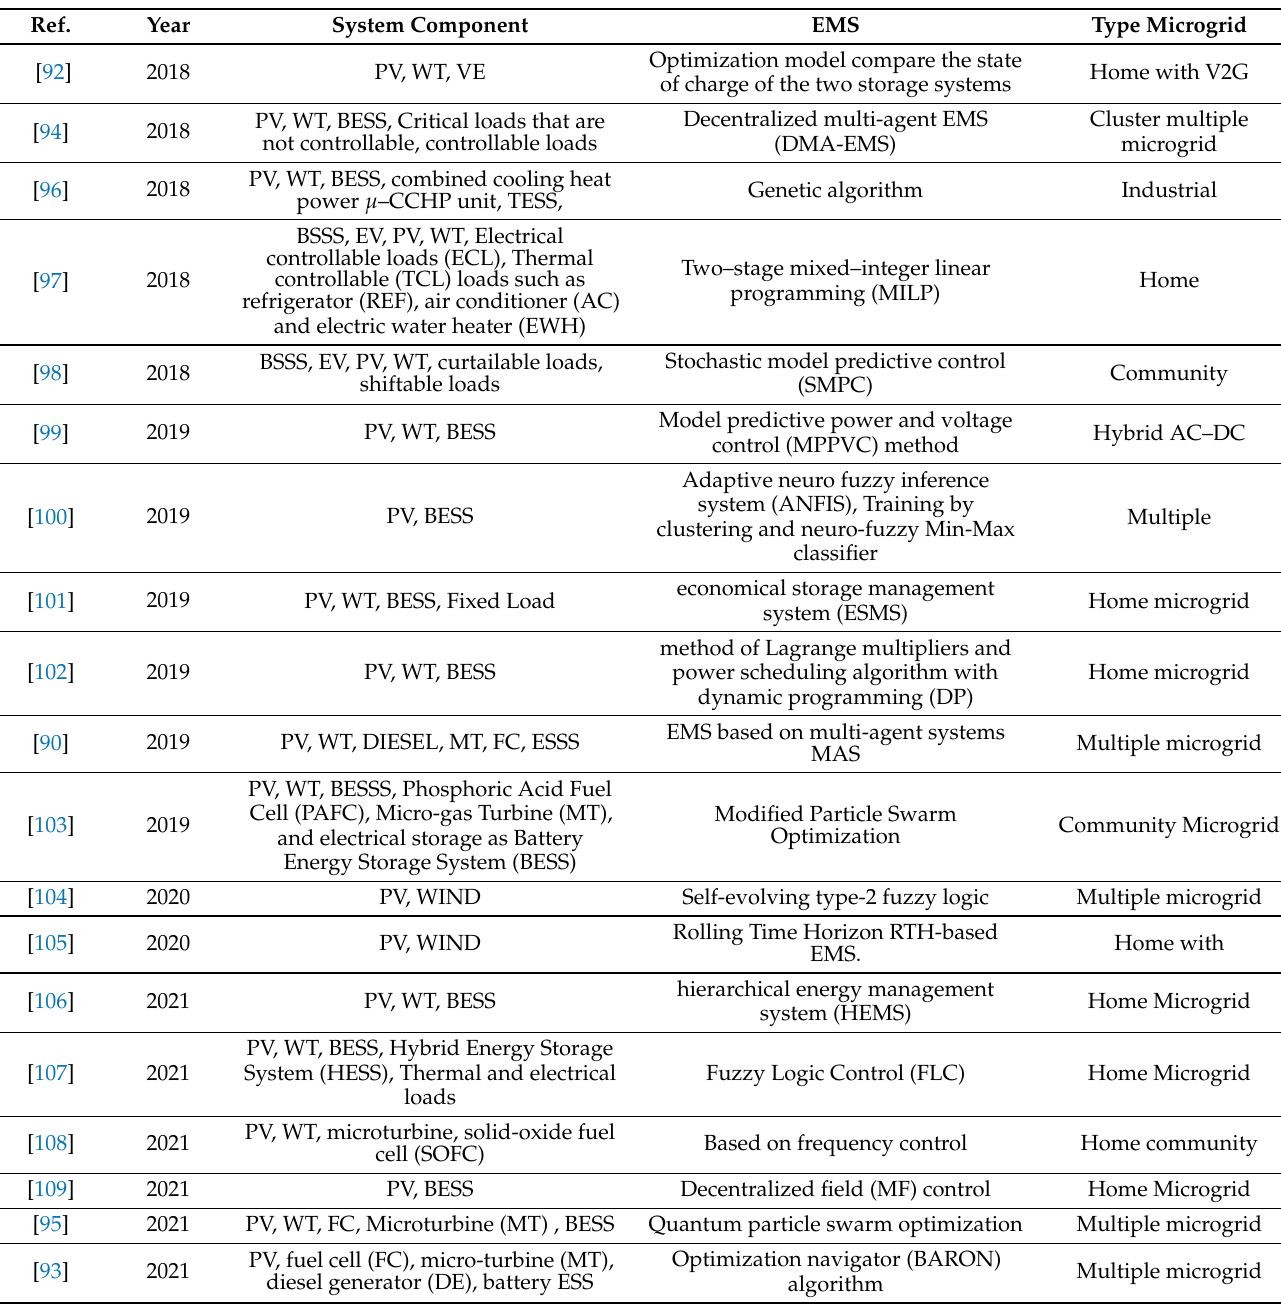
Table 5. EMS system in a microgrid: Low-Voltage